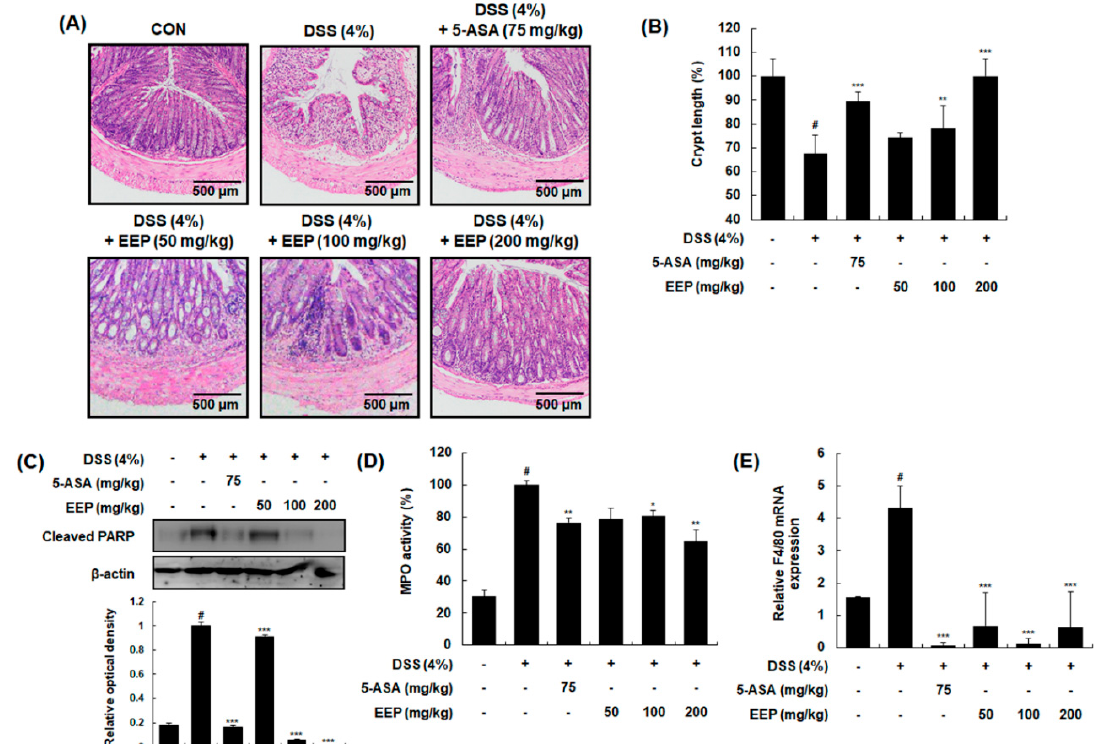
Figure 3. Effects of EEP on histological changes in DSS-induced colitis mice. ( A ) Representative sections of colonic tissues from mice administrated 4% DSS in drinking water (ad libitum) for 9 days with or without EEP. 5-ASA (75 mg/kg/day p.o.) was used as a positive control. Histological changes were determined by H&E staining. ( B ) Changes in crypt length were measured. ( C ) Whole proteins were prepared from DSS-exposed colonic tissues and subjected to Western blotting to determine expression level of cleaved PARP. β -Actin was used as an internal control. ( D ) Colon segments from mice were used to determine myeloperoxidase (MPO) levels. ( E ) Total RNAs were prepared from DSS-exposed colonic tissues and used for qRT-PCR. Using specific primers, mRNA expression levels of F4/80 were determined and normalized against β -actin. Values are presented as means ± SDs ( n = 10). # p < 0.05 compared with the vehicle-treated control group, and * p < 0.05, ** p < 0.01, *** p < 0.001 compared with the DSS-induced colitis group.